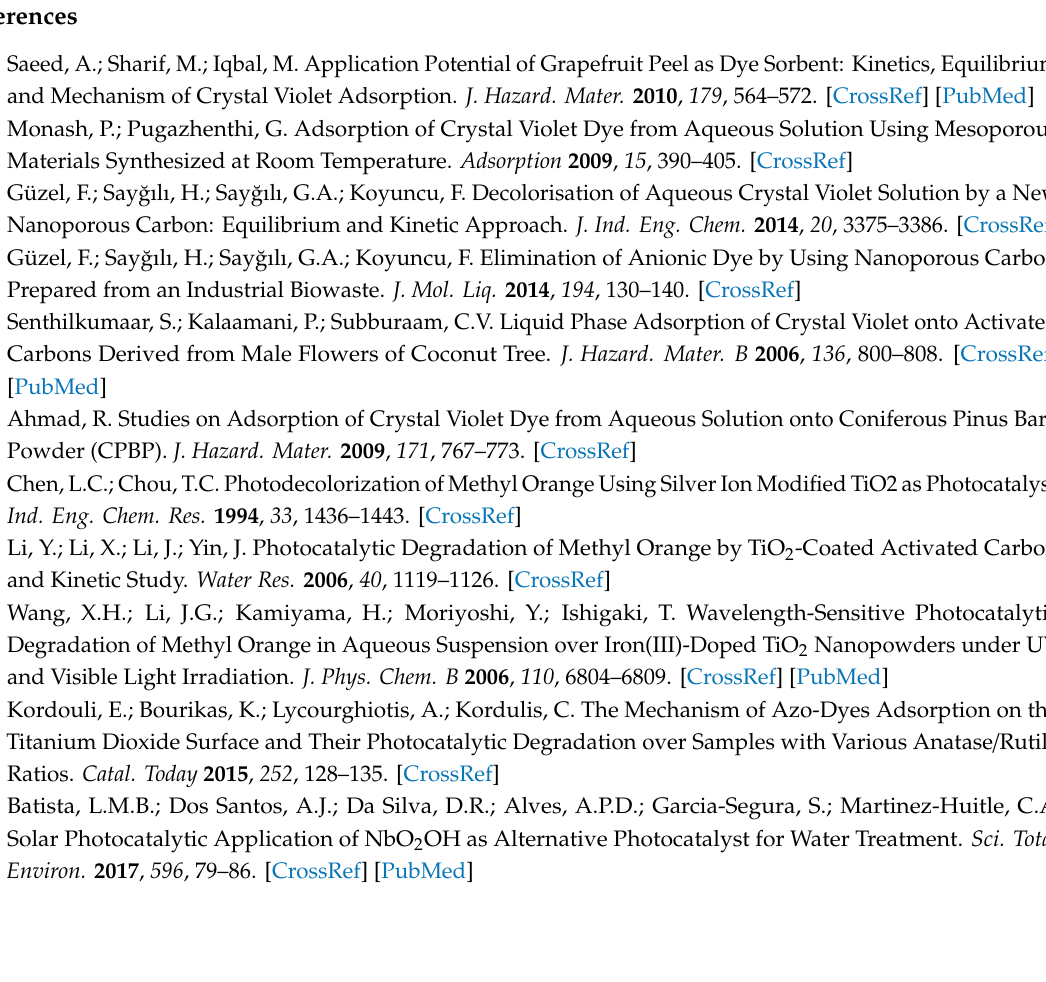
Figure S1: Photocatalytic reactor (Heraeus) with the TQ 150 lamp situated in a glass cooling jacket filled with re-circulated deionized water and immersed in the reaction mixture, Figure S2: Relative spectral radiant flux of low pressure Hg lamp (TQ 150) being in a glass cooling jacket filled with re-circulated de-ionized